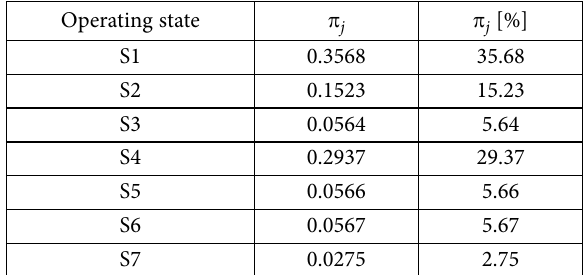
Table 5. Stationary probabilities of the embedded Markov